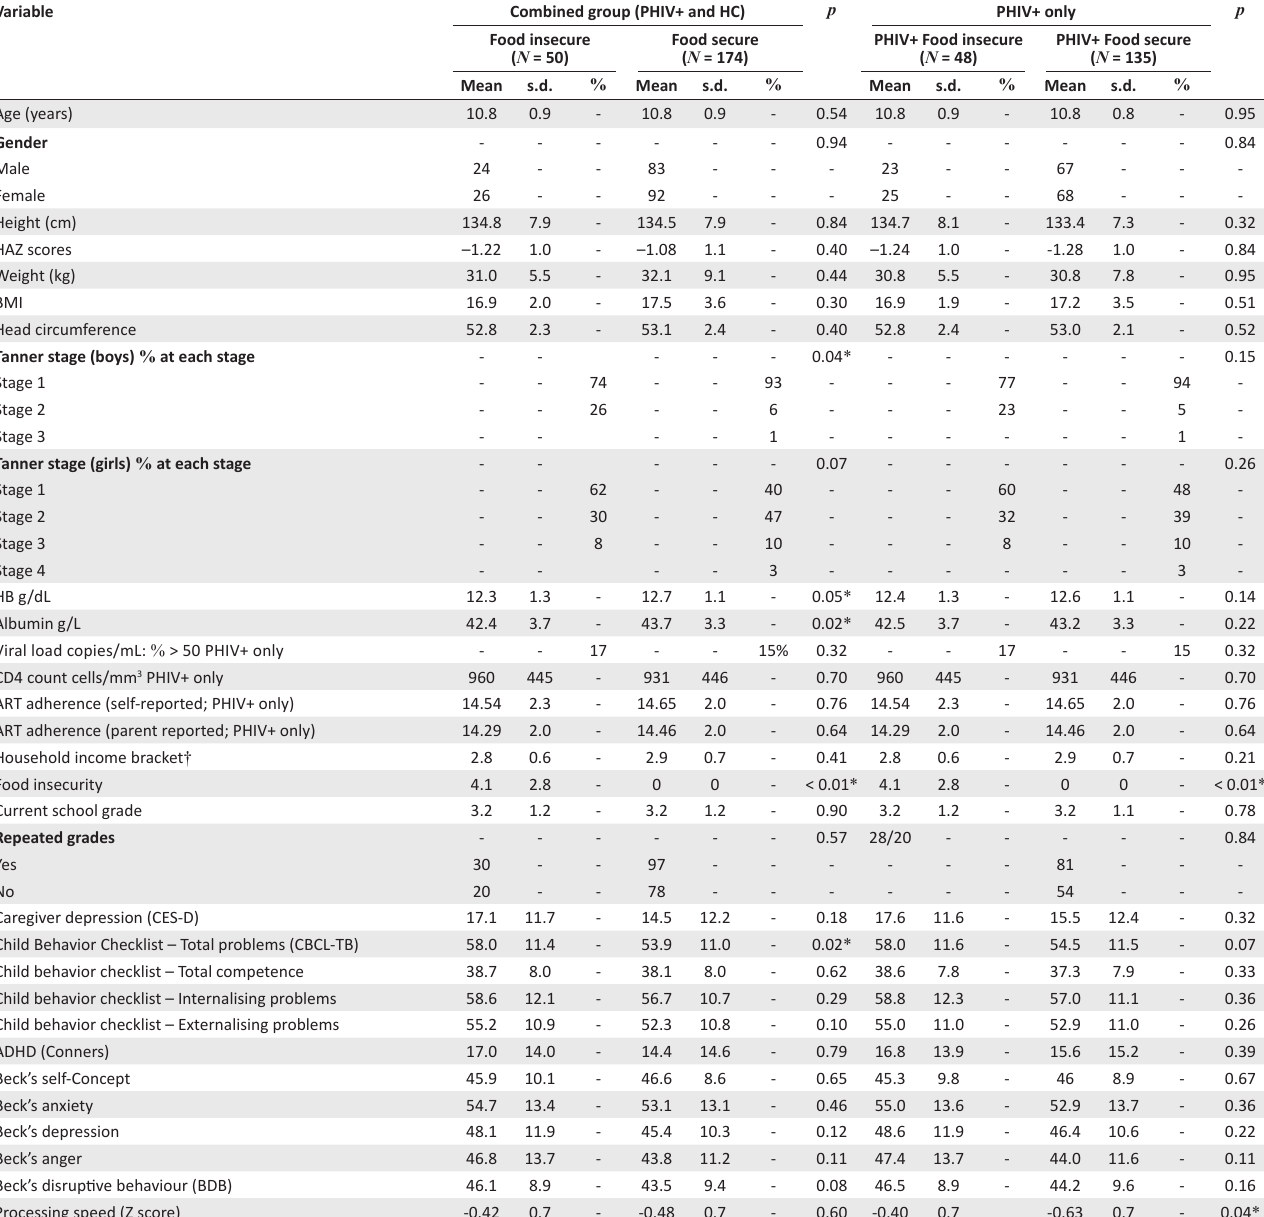
TABLE 2: Baseline demographic and clinical characteristics of the cohort, comparing food insecure and food secure.